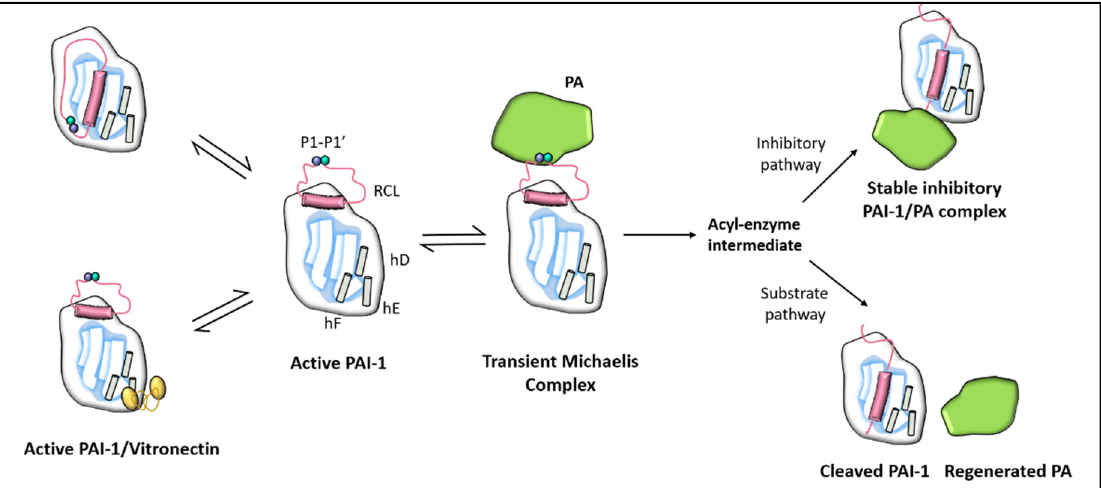
Figure 1. Schematic depiction of the PAI-1 conformation as well as its interaction with vitronectin cofactor and plasminogen activators (PA). PAI-1 contains two distinct interactive domains: a reactive centre loop (RCL) and a flexible joint region with helix D (hD), helix E (hE), and helix F (hF) binding sites. The P1-P1’ bond is broken to create an acyl–enzyme intermediate following the creation of a non-covalent PAI-1/PA Michaelis complex. The reaction takes place through a branched pathway, leading either to the formation of an irreversible inhibitory complex or to the generation of cleaved PAI-1 due to the intermediate acyl–enzyme hydrolysis.